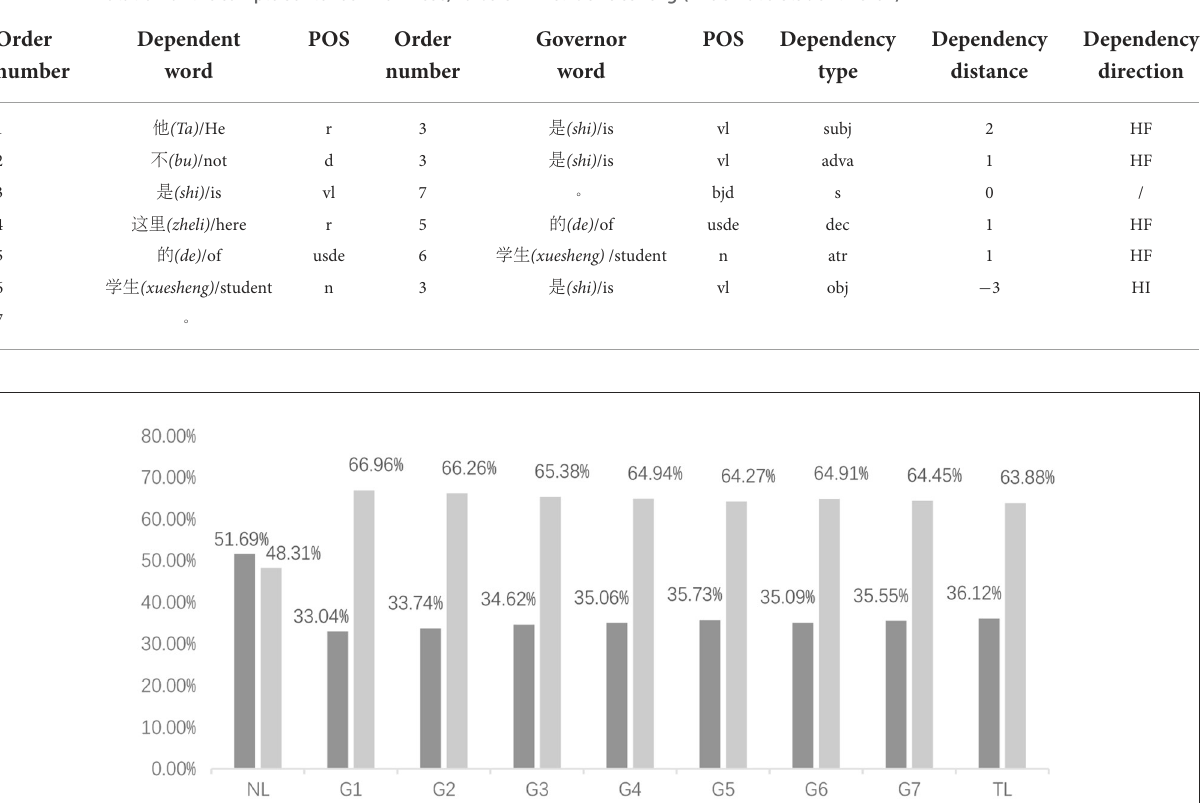
TABLE 2 Annotation of the sample sentence in Chinese, Ta bu shi zheli de xuesheng (“He’s not a student here.”).